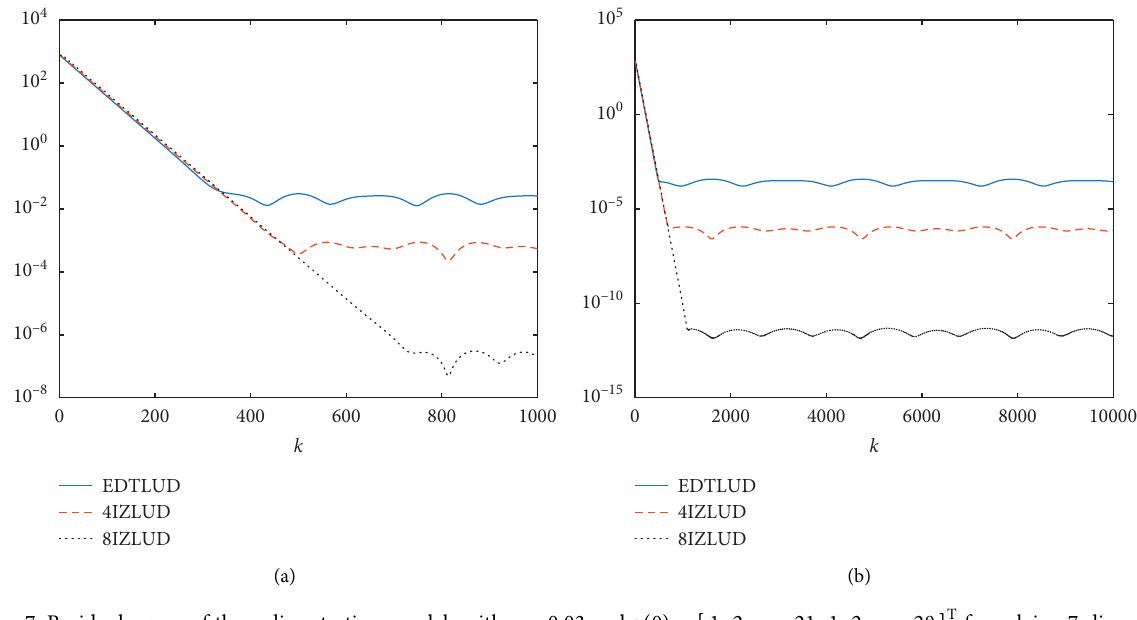
Figure 7: Residual errors of three discrete-time models with g � 0 . 03 and s ( 0 ) � 1 2 · ·· 21 1 2 · · · 28 􏼂 􏼃 T for solving 7-dimensional time-varying LU decomposition problem in Example 3. (a) When η � 0 . 01 s. (b) When η � 0 . 001